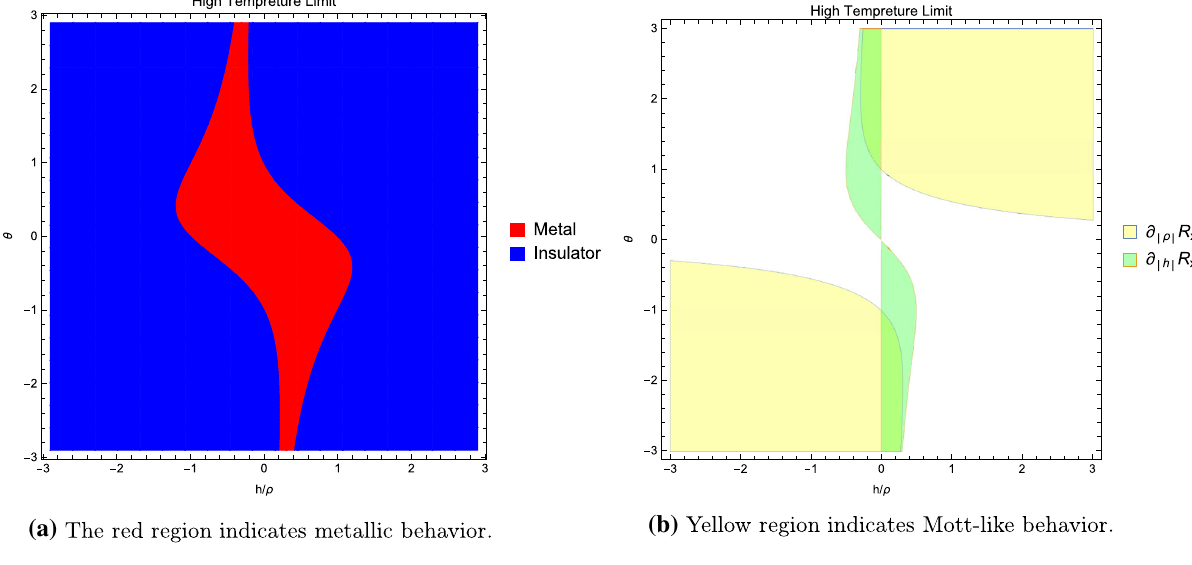
Fig. 1 Parameter space in terms of θ and h /ρ in the high temperature limit. Note that θ ≡ L ( 0 , 1 ) ( 0 , 0